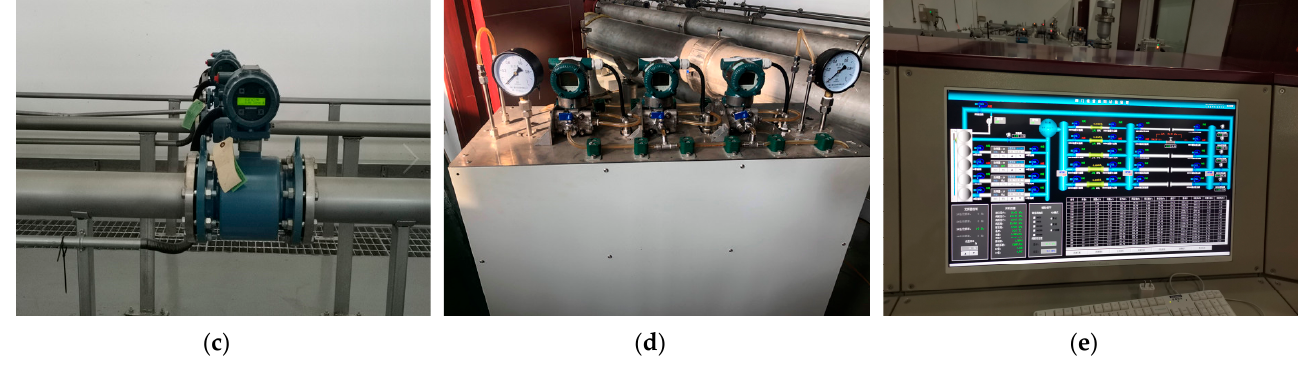
Figure 14. Valve flow test and acquisition system. ( a ) Valve flow test system; ( b ) valve installed in the test system; ( c ) electromagnetic flowmeter; ( d ) pressure drop sensor; ( e ) test data acquisition system.